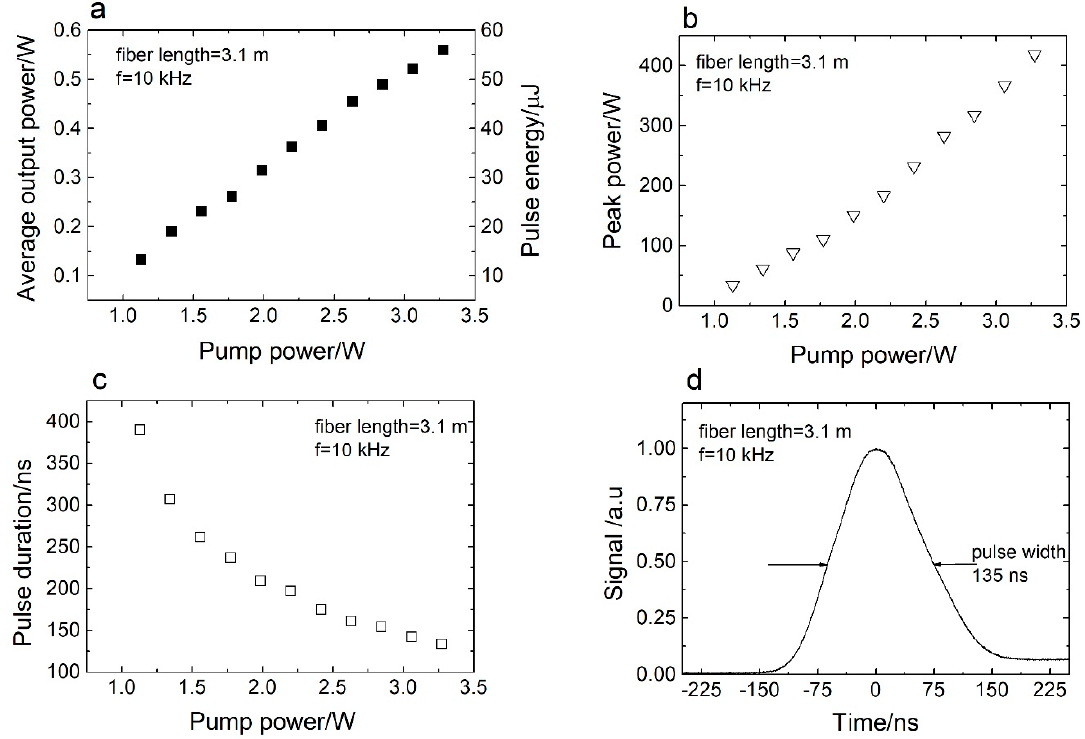
Figure 3. ( a ) Average output power and pulse energy versus pump power. ( b ) Peak power versus pump power. ( c ) Pulse duration versus pump power. ( d ) Pulse shape recorded at 10 kHz. The fiber length used in the experiment was 3.1 m.